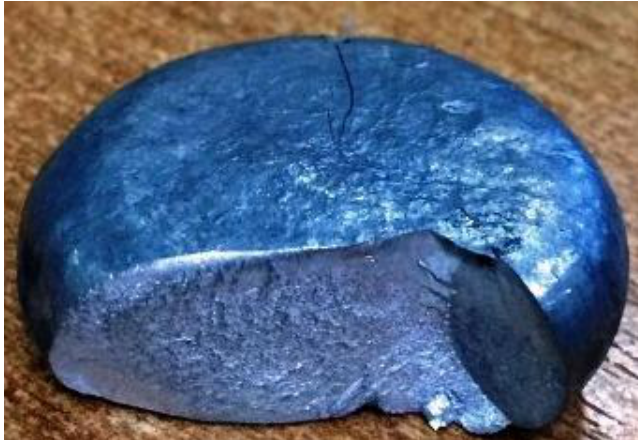
Figure 4. Macrostructure of master alloy 25Mg–50Zn–25Nd.